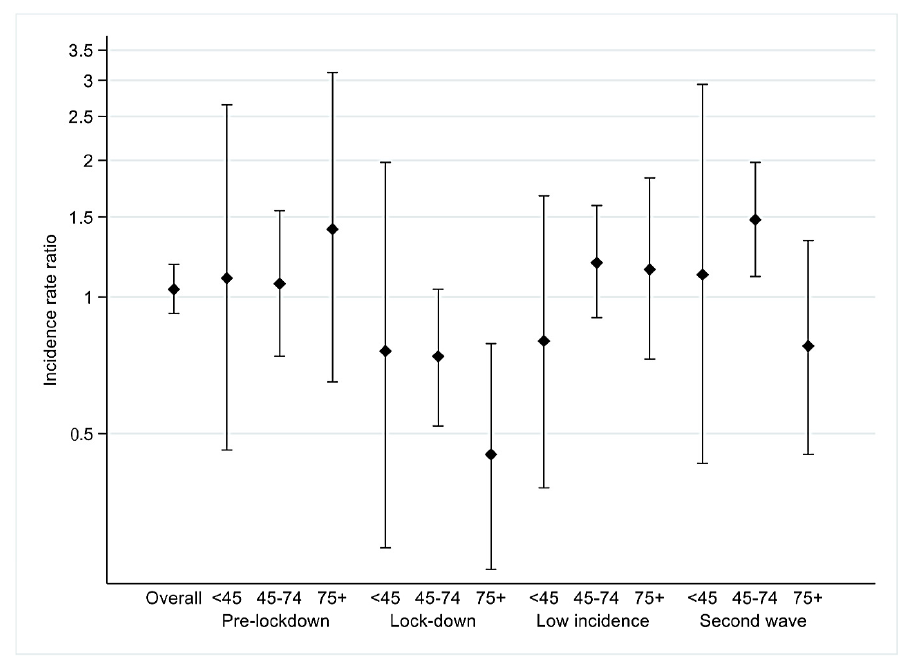
Figure 1. Incidence Rate Ratio of new cases in 2020 compared to 2019, by period and age group. This trend in new cancer diagnoses fits well with the extension of the invitations to mammography screening and the number of mammograms performed (Figure 2). The number of new cancers (45–74-year-olds) closely follows the number of mammograms performed. In 2020, the suspension of invitations during the lockdown was followed by a modest reduction during the summer period (August) which, however, is shorter and less pronounced than the usual summer reduction in screening activities observed in 2019. Immediately after the summer, however, the resumption of invitations led to a rapid increase of cancer diagnoses in women aged